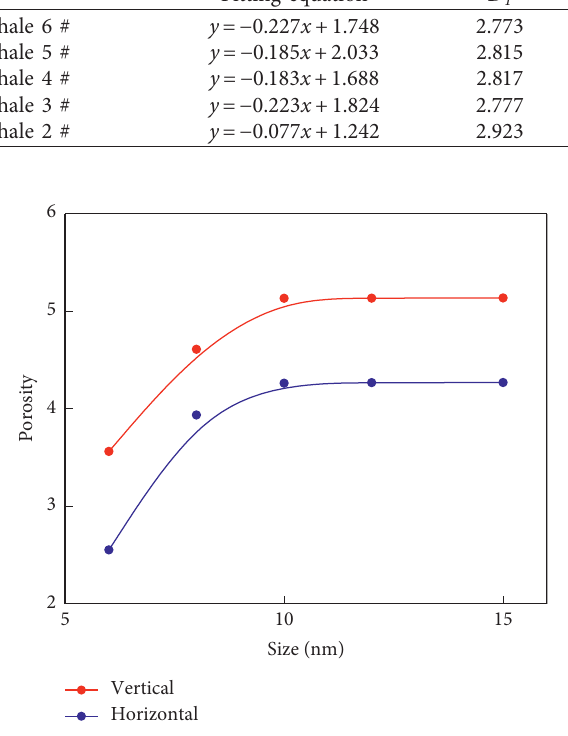
Figure 9: The relationship between shale sample size and